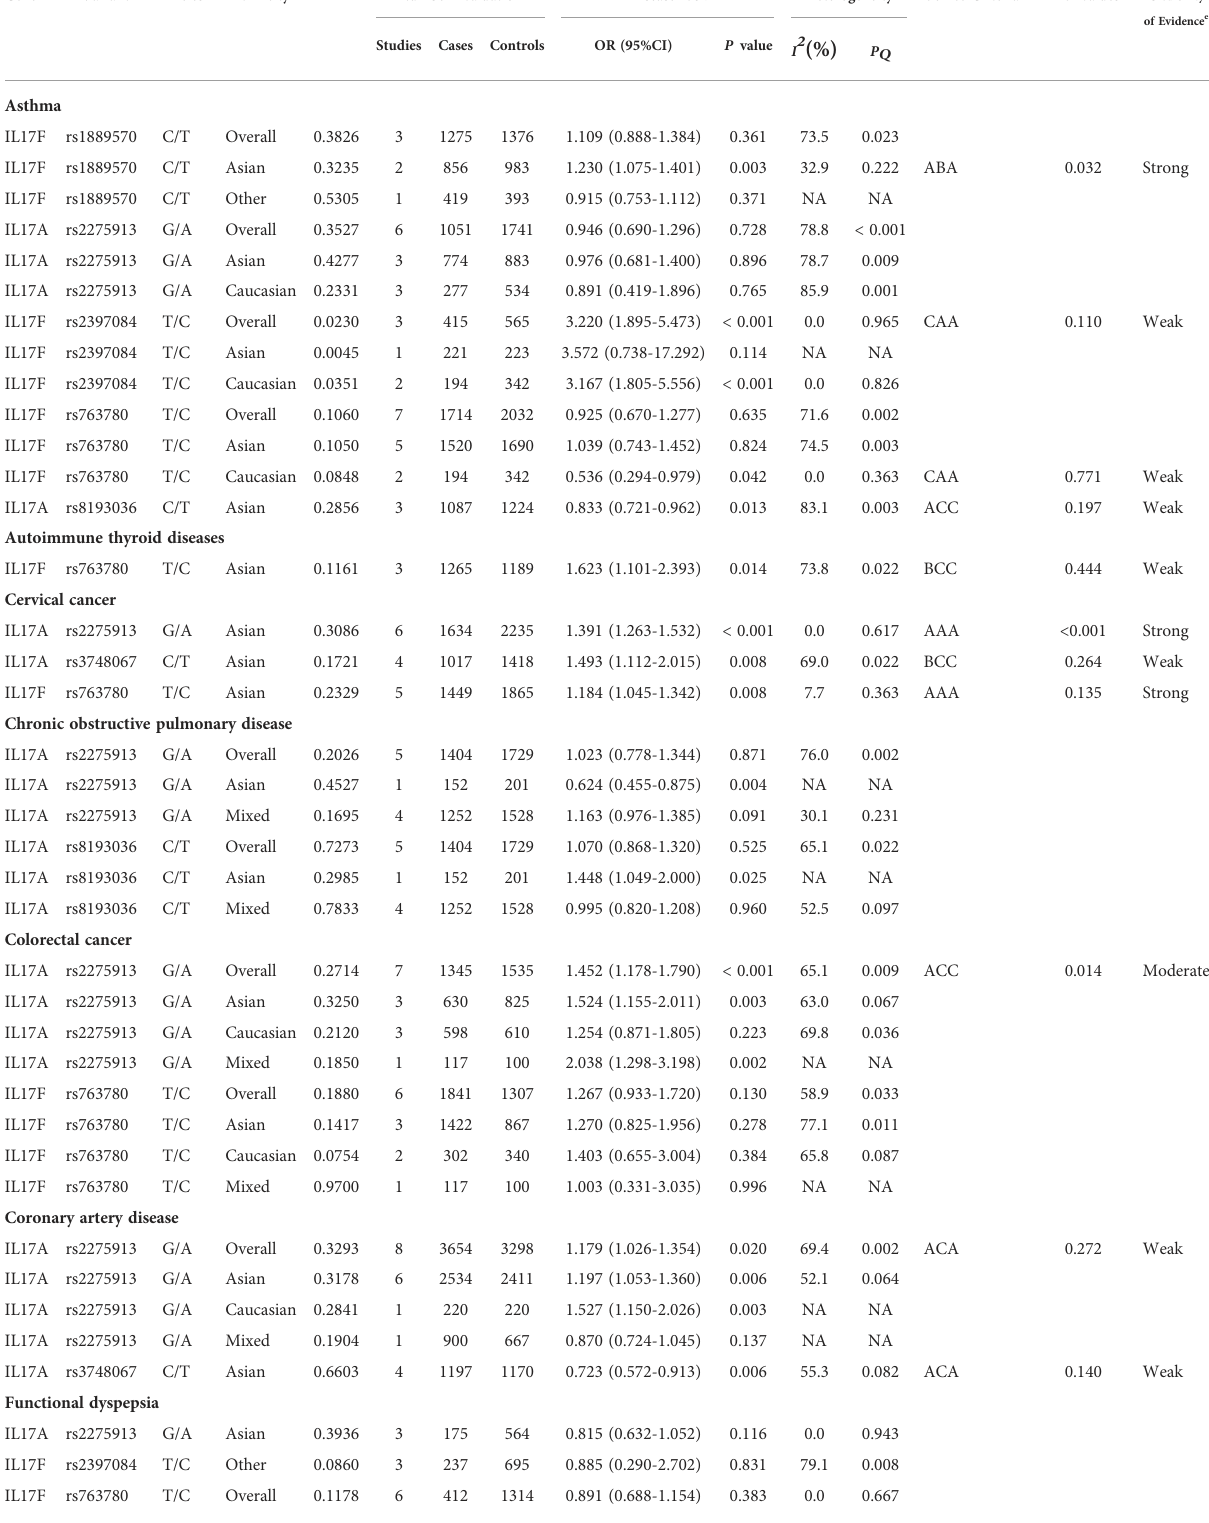
TABLE 1 Associations between variants in the IL-17 family genes associated with risk of human disease in meta-analysis under additive model (at least 3 datasets). Gene Variant Alleles a Ethnicity MAF